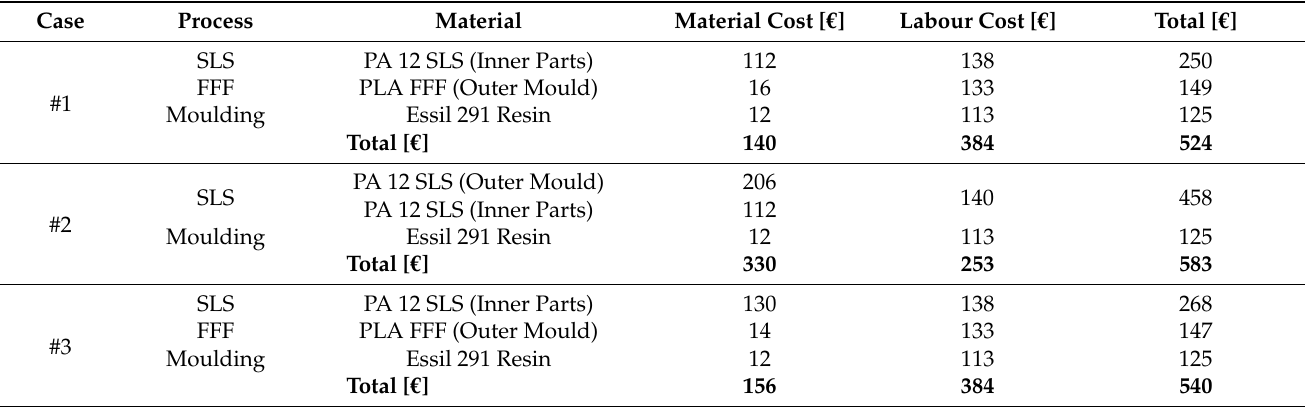
Table 2. Cost of the surgical planning prototypes.